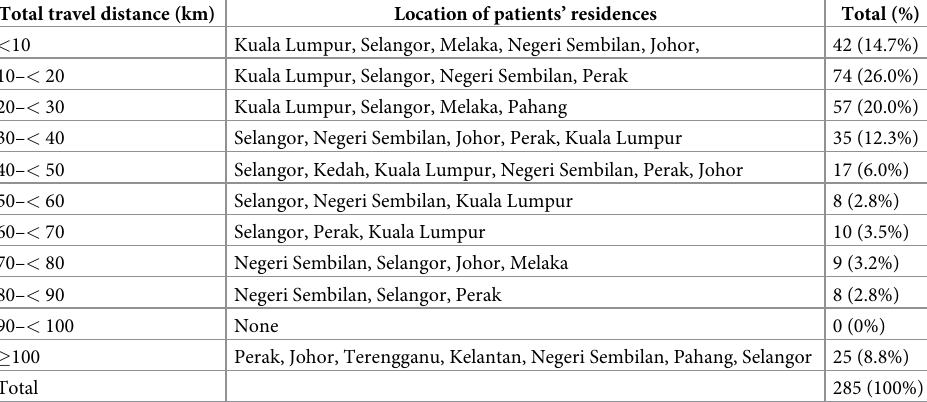
Table 6. Travel distance for the respondents if they had gone for mammogram screening. Total travel distance (km) Location of patients’ residences Total